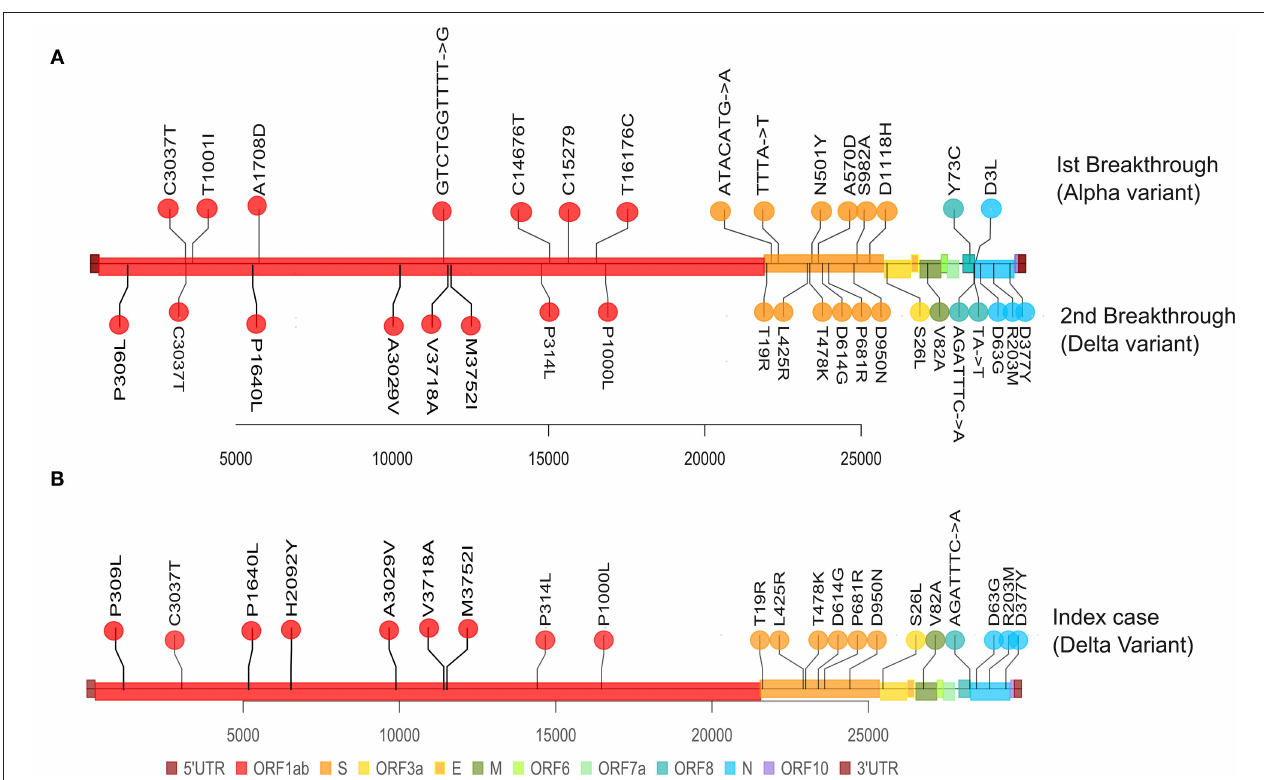
FIGURE 3 | Representation of mutations within SARS-CoV-2 genome for the Patient’s paired samples and the single index case sample. The plot displays the different locations of the mutations observed in each sample, with different colors corresponding to different genes. (A) Represents the mutations from the Patient’s first breakthrough sequence Alpha variant (superiorly) and the second breakthrough sequence Delta variant (inferiorly). (B) Represents the mutations from the index case’s breakthrough sequence Delta variant